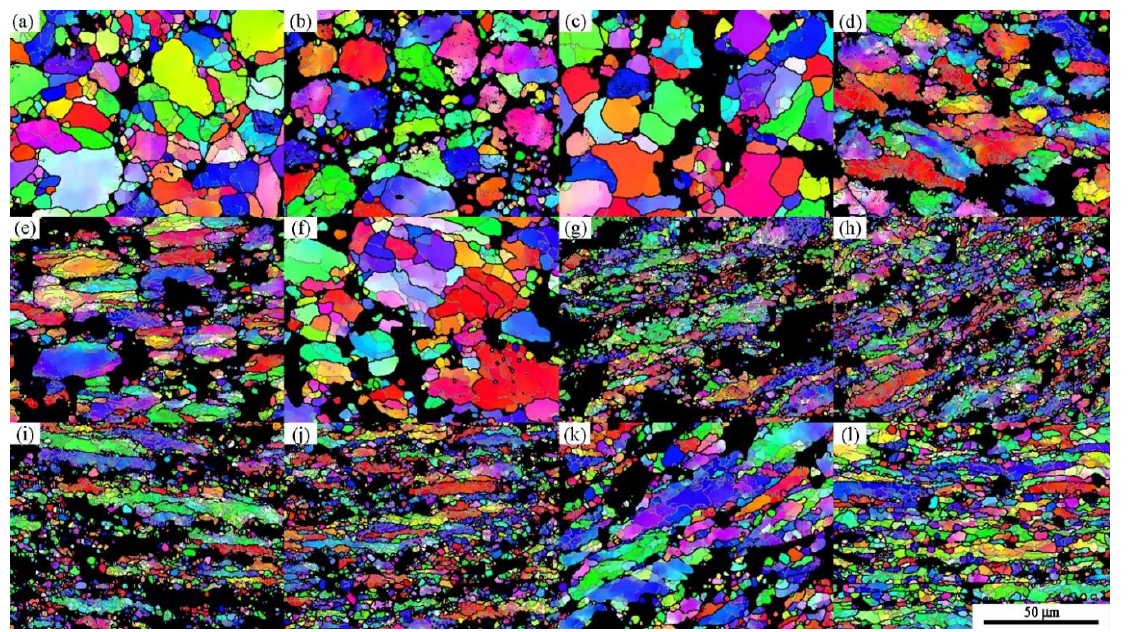
Figure 5. An EBSD image of the composite matrix microstructure at a deformation temperature of 300 °C for ( a ) ε = 0.12 and 0.83 s − 1 ; ( b ) ε = 0.13 and 0.26 s − 1 ; ( c ) ε = 0.17 and 0.05 s − 1 ; ( d ) ε = 0.37 and 2.48 s − 1 ; ( e ) ε = 0.40 and 0.8 s − 1 ; ( f ) ε = 0.45 and 0.15 s − 1 ; ( g ) ε = 0.58 and 3.85 s − 1 ; ( h ) ε = 0.63 and 1.25 s − 1 ; ( i ) ε = 0.63 and 4.18 s − 1 ; ( j ) ε = 0.66 and 1.32 s − 1 ; ( k ) ε = 0.73 and 0.24 s − 1 ; ( l ) ε = 0.76 and 0.26 s − 1 .